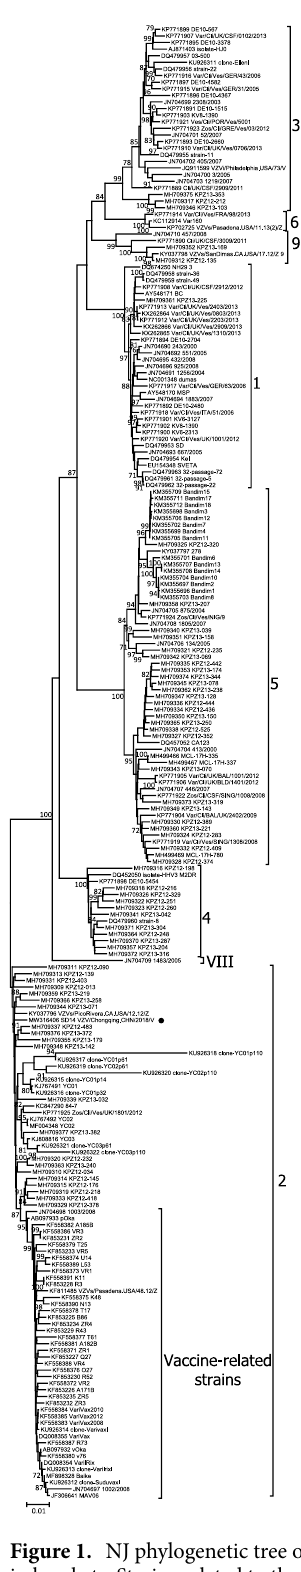
Figure 1. NJ phylogenetic tree of 2880 concatenated SNPs from 223 VZV genomes. Clades are indicated in brackets. Strains related to the vaccine strain Oka are also indicated in bracket. SD14 de novo sequence is indicated by a black circle. Bootstrap values greater than 70% are indicated. The corresponding ML tree is shown in Fig.